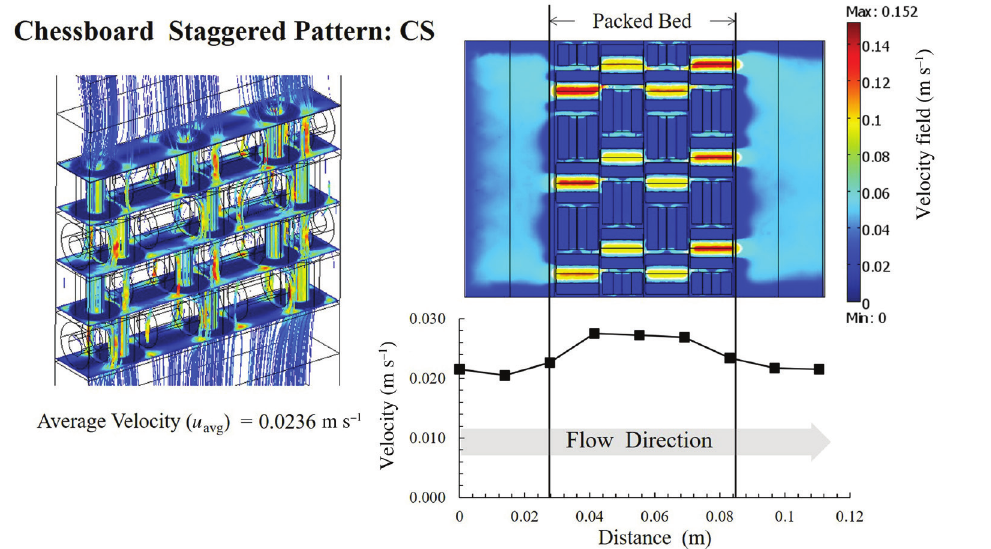
Fig. 5 – Total velocity distribution of CS packing